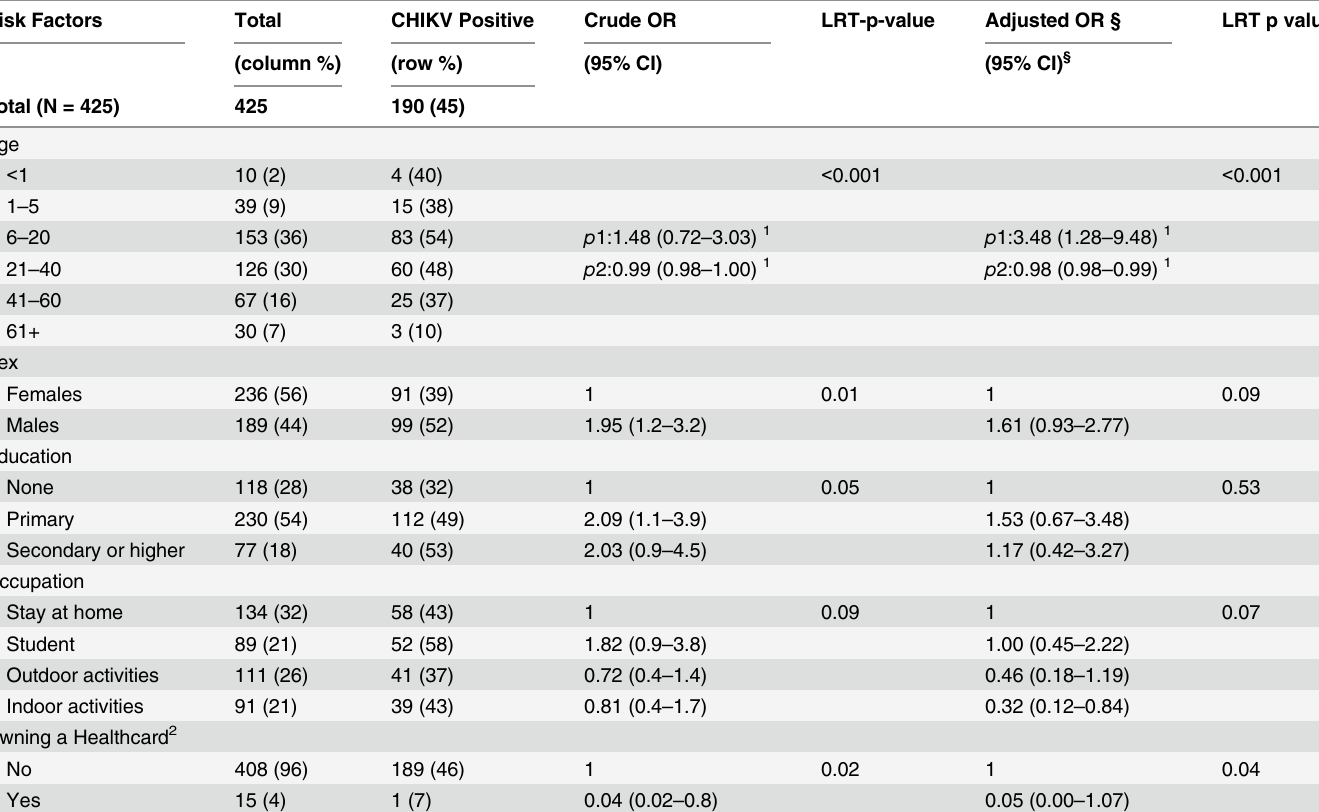
Table 2. The association of selected risk factors to CHIKV infection (after adjusting for age, sex, occupation and healthcard), Trapeang Roka, Cam- bodia,